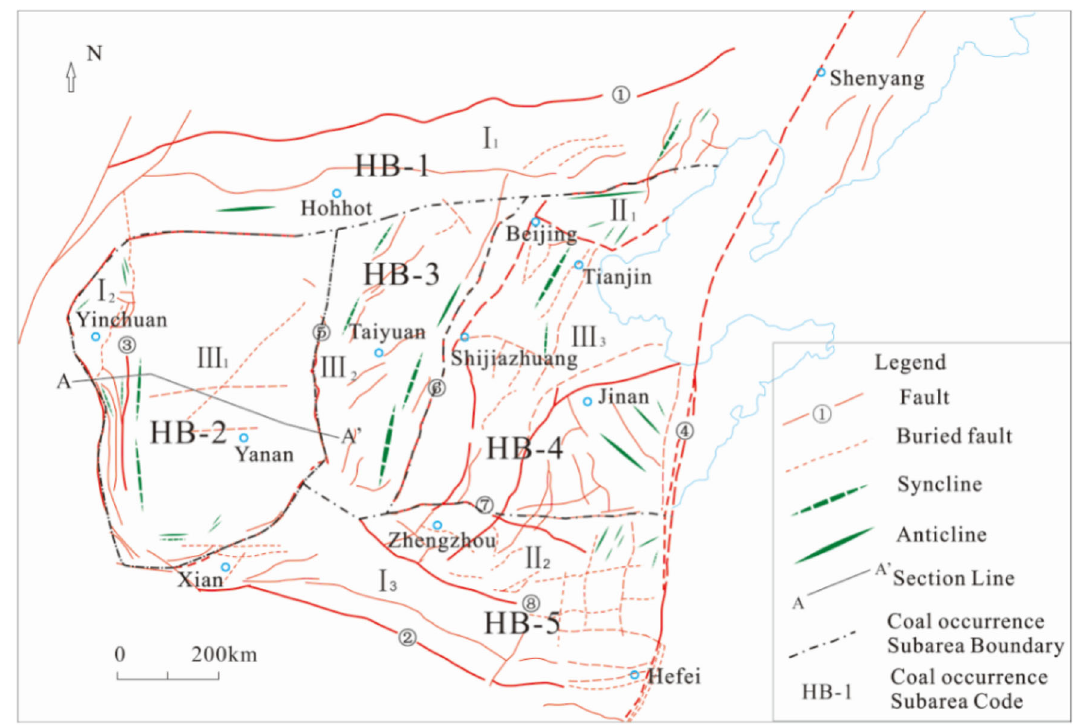
Fig. 5 Distribution of coal-controlling structures and deformation of coal measures in the North China coal occurrence structural area. (cid:2) Northern marginal fault in the NCCA; ` Southern marginal fault in the NCCA; ´ Western marginal fault belt in the Ordos Basin; ˆ Tanlu fault; ˜ Lishi fault; Þ Zijingguan fault; þ Pangusi–Fengpei fault; ¼ Southern marginal thrust fault belt in the coal-bearing basins in North China; I Northern marginal compressional deformation belt in North China; I 2 –Western marginal compressional deformation belt in North China; I 3 – Southern marginal compressional deformation belt in North China; II 1 –Coalfields in Northern North China; II 2 –Western Henan and Xuhuai coal- bearing areas in Southern North China; III 1 –Weak deformation subarea in the Ordos Basin; III 2 –Shanxi block; III 3 –Extensional deformation subarea in Eastern North China